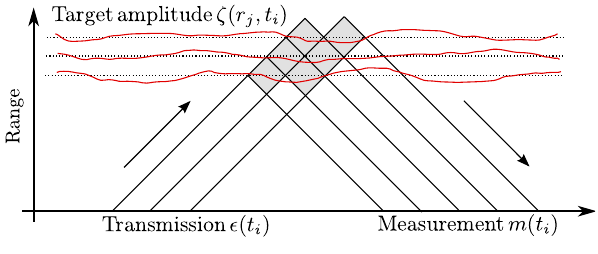
Fig. 1. Simplified range-time diagram of backscatter from a strong narrow region. In this example there are two transmit samples and three ranges that cause backscatter. The red lines visualize the changing amplitude of backscatter at each range. The gray area represents the area where the backscatter of one sample originates from (assuming boxcar impulse